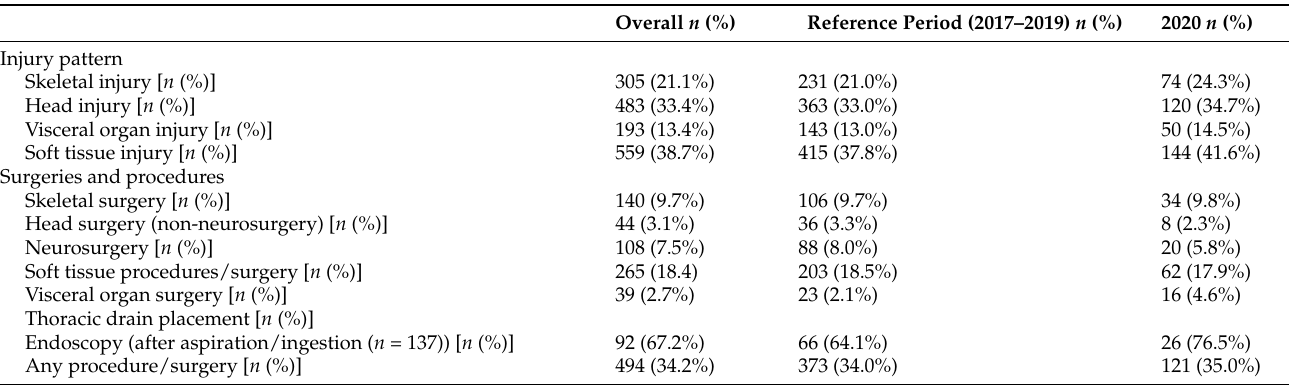
Figure 6. Trendsininjurypatternsandprocedures. SMR=standardizedmorbidityrate,CI=confidenceinterval. Figure 6. Trends in injury patterns and procedures. SMR = standardized morbidity rate, CI = confi- dence interval. Table 3. Injury patterns and